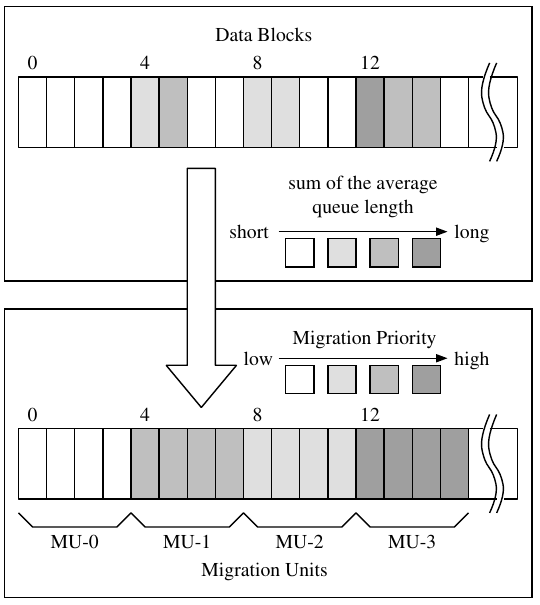
Fig. 4. An example of getting the migration